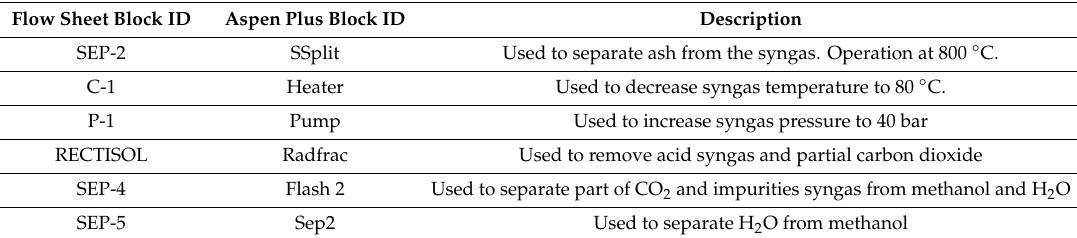
Table 3. Description of Aspen plus blocks used in Rectisol.